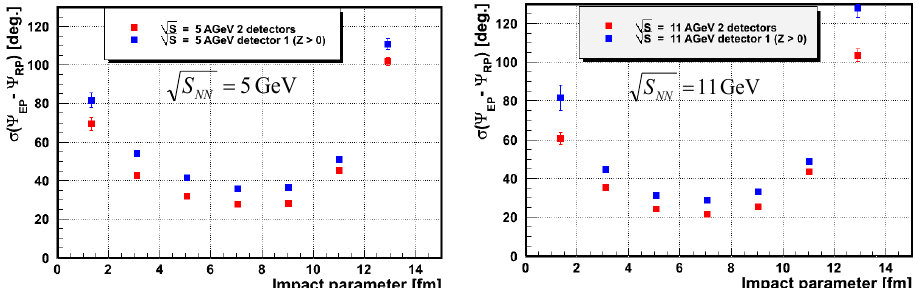
Figure 2. The di ff erence between the reconstructed event plane and true reaction plane for the beam √ √ s NN = 5 (left panel) and s NN = 11 GeV (right panel). Blue (red) dots correspond to one energies arm (two arms) of FHCal